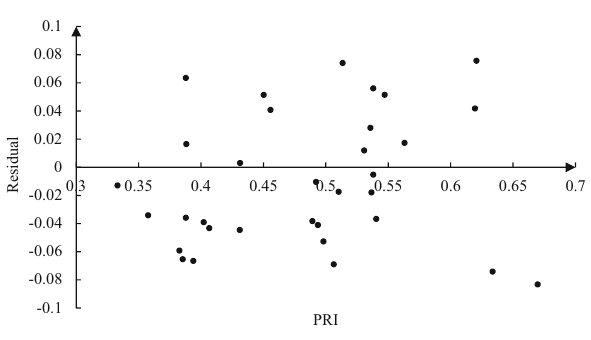
Fig. 6 Residual plot of PRI